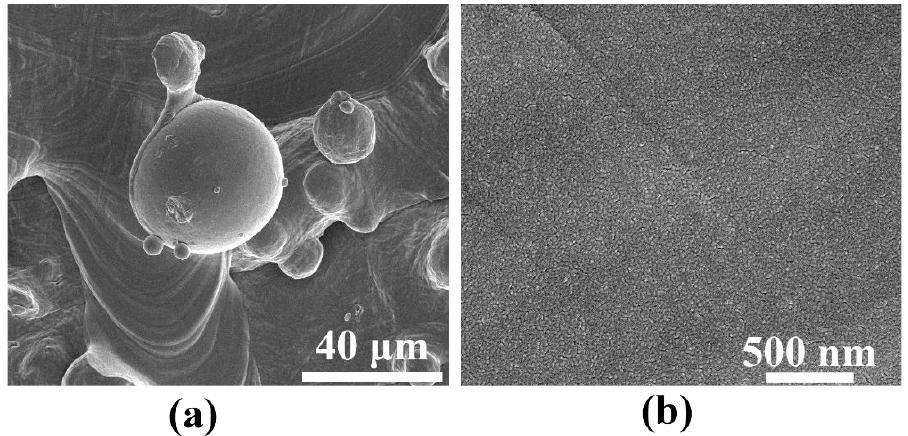
Figure 6. SEM images of Ti 3D surface after PBF-LB process with silver deposit (0.02 mg/cm 2 ) in ( a ) low and ( b ) high magnification.